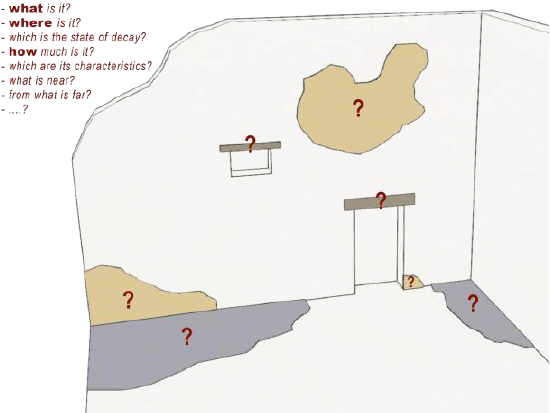
Figure 2: Example of different elements in the archaeological site of Herculaneum and related base-questions to build the Maintenance GIS.